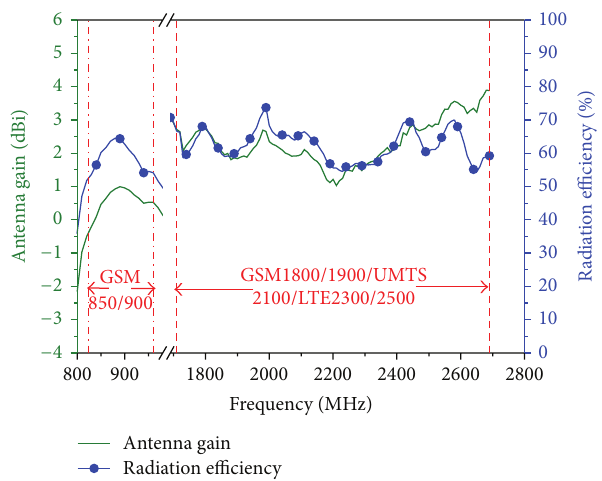
Figure 9: Measured antenna gain and radiation efficiency for the fabricated antenna.